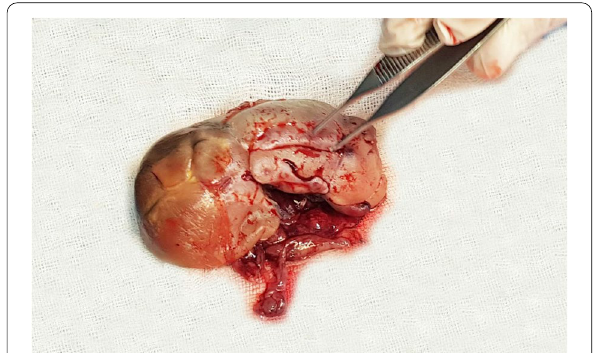
Fig. 7 The extracted fetal mass after opening of the membranes showing a head and flexed upper and lower